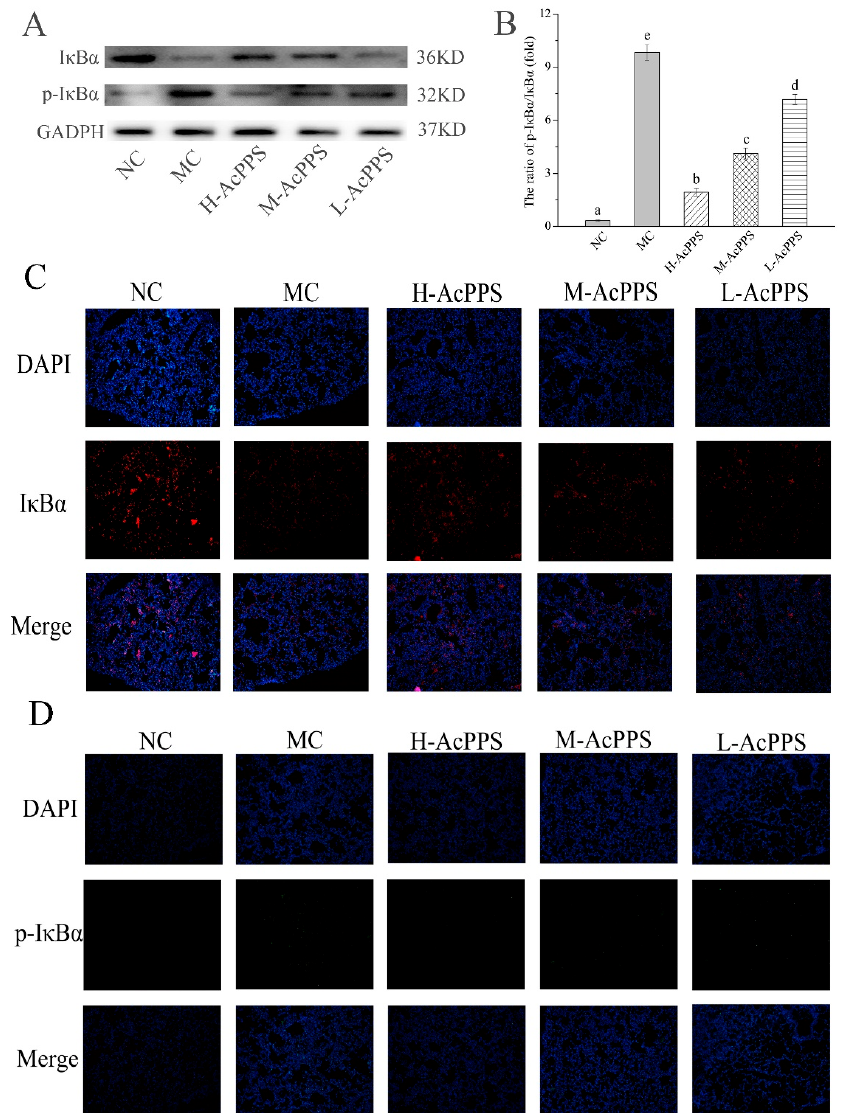
Figure 6. AcPPS adjusted NF- κ B signal pathway in mice. ( A ) Effects of AcPPS on the expression levels of p-I κ B α and I κ B α based on Western blotting assay. ( B ) p-I κ B α /I κ B α ratios. ( C ) Effects of AcPPS on I κ B α level based on immunofluorescence (IF) assay in lung (200 ×). ( D ) Effects of AcPPS on p-I κ B α level based on IF assay in lung (200 ×).